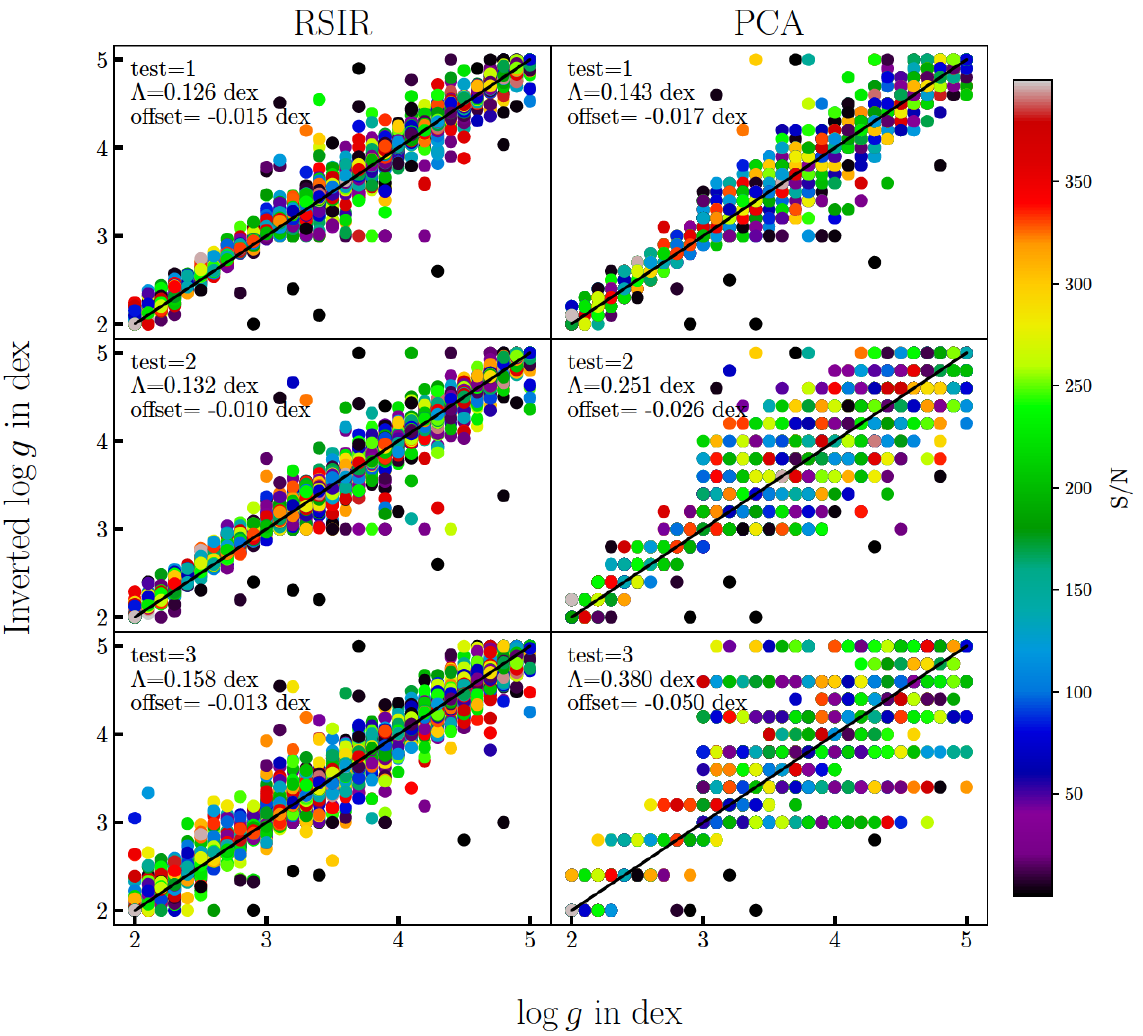
Figure A1. Results of the surface gravity inversion for the synthetic A to K